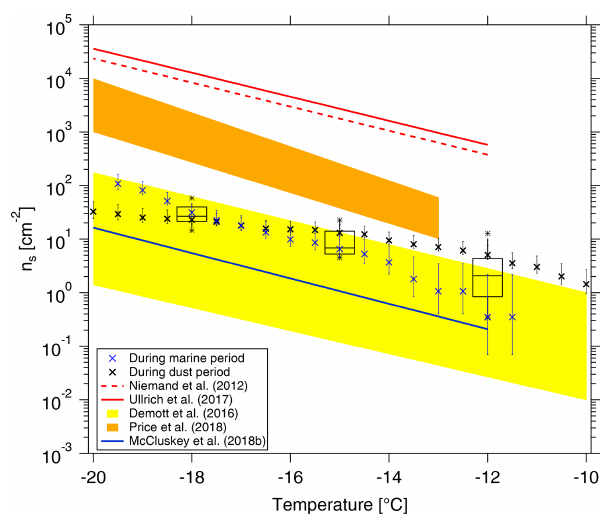
Figure 9. Cumulative n s as a function of temperature in this study is shown by black boxes. The boxes represent the interquartile range. Whiskers represent 10th and 90th percentiles. Data not included be- tween the whiskers are plotted as an outlier with a star. Two n s pa- rameterizations (Niemand et al., 2012; Ullrich et al., 2017) for pure desert dust are shown in dashed and solid red lines, respectively. n s parameterizations from McCluskey et al. (2018b) for pristine SSA over the northeast Atlantic are shown as a solid blue line. We also make comparisons to recent data from airborne measurements in a dust layer by Price et al. (2018) in brown shading and from nascent laboratory-generated and ambient SSA by DeMott et al. (2016) in yellow shading, respectively. n s during the cleanest marine (CVAO 1585) and dustiest (CVAO 1591) periods are shown as blue and black crosses,